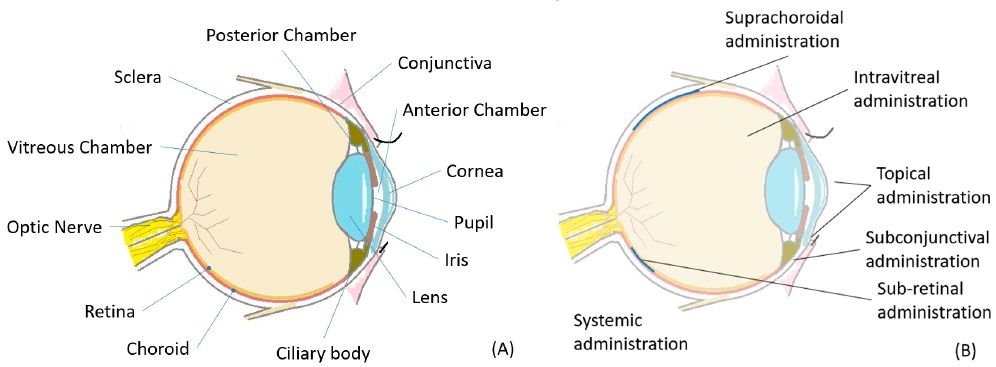
Figure 1. Schematic representation of the anatomical structure of the eye ( A ). Schematic representation of drug delivery routes to the eye ( B ).